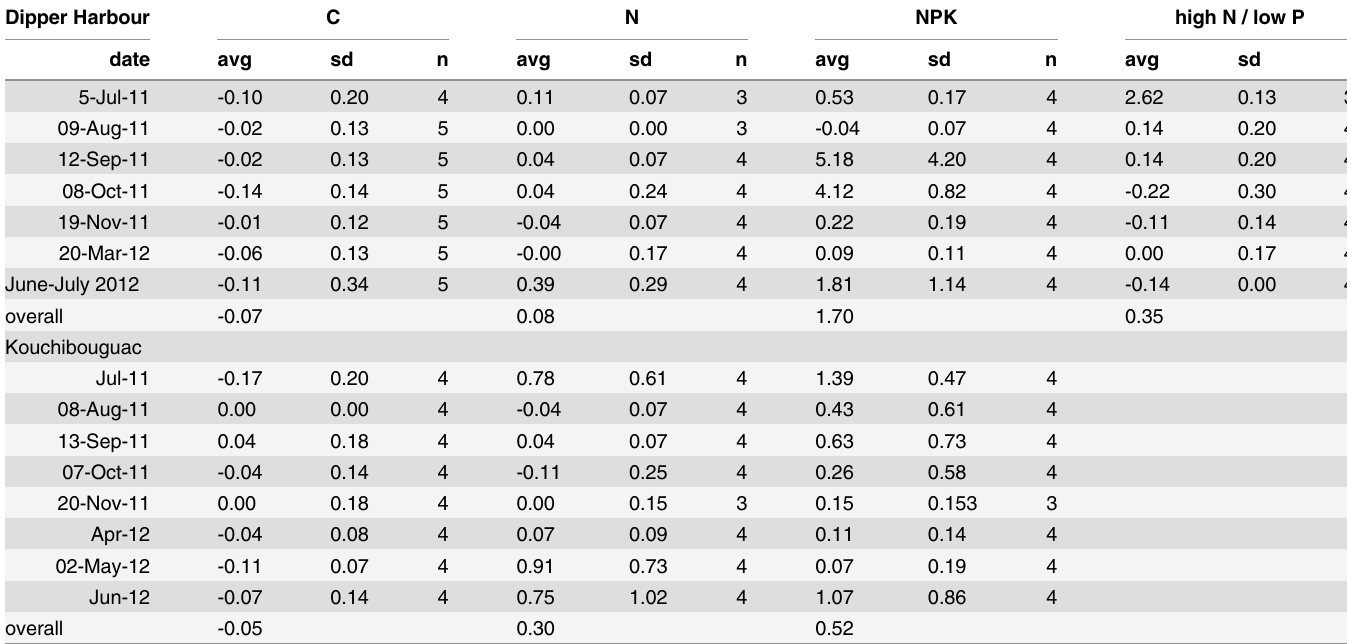
Table 5. Average N 2 O fluxes by sample event in μ moles m -2 hr -1 . Dipper